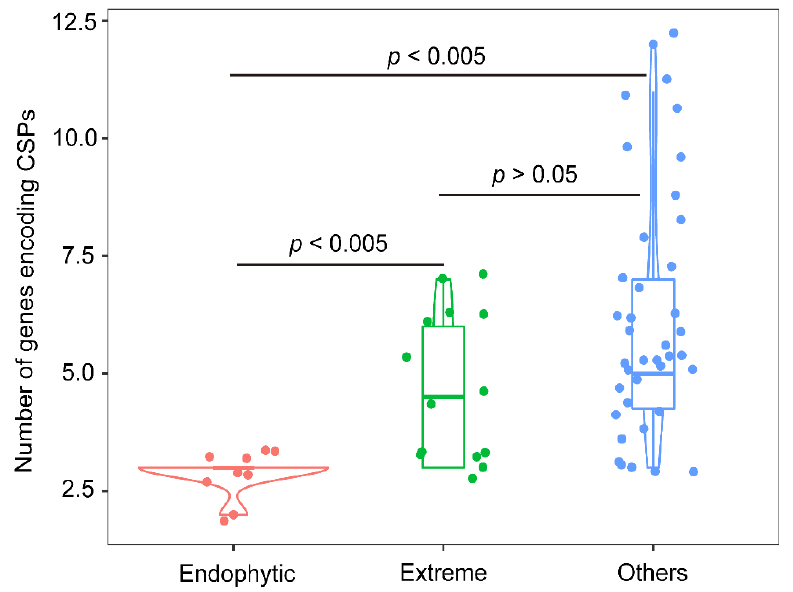
Figure 6. Distribution of cold shock protein (CSP)-coding genes in the genomes of Rhodococcus strains from different environments. The violin with a box plot shows the median and interquartile range, and the width of the violin represents the density distribution of the number of CSP-coding genes. p values were determined by the two-tailed Wilcoxon test. The number of Rhodococcus strains from endophytic, extreme, and other environments are 8, 13, and 39, respectively.